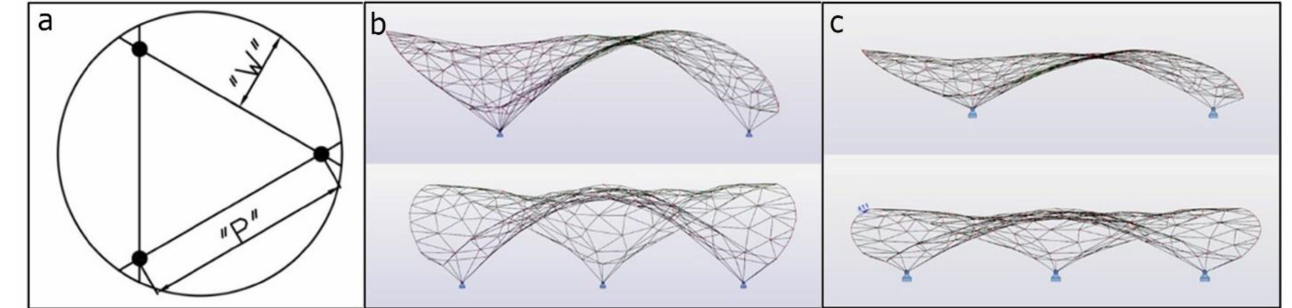
Figure 5. ( a ) Analysed canopy plan, with supports location (dots) and representation of the ratio between cantilever and span between supports; ( b ) side views of the canopy with the highest curvature of the geometry (The curvature height to the support span ratio: 1/3); ( c ) side views of the canopy with the slightest curvature of the geometry (The curvature height to the support span ratio: 1/5) (authors